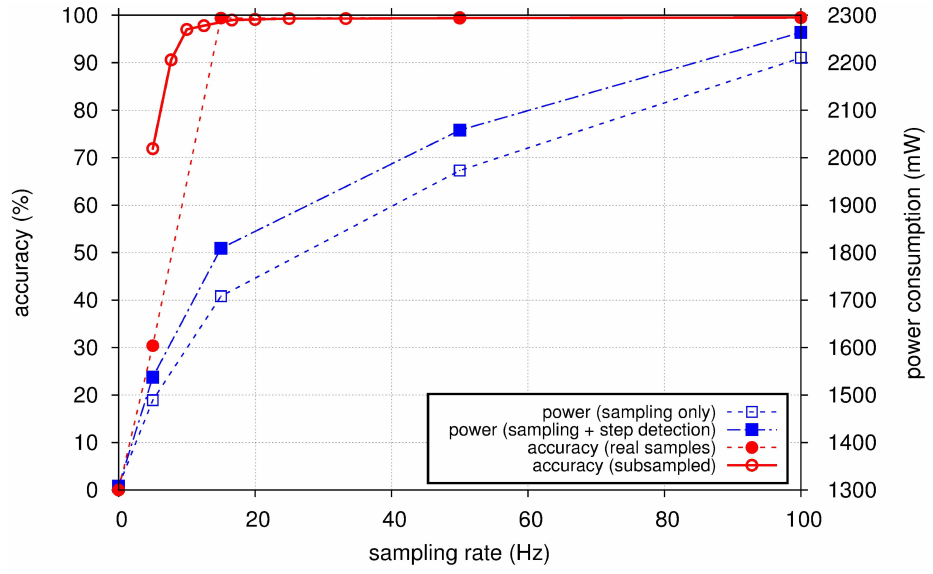
Figure 7. Power consumption and accuracy of step detection with respect to the sampling